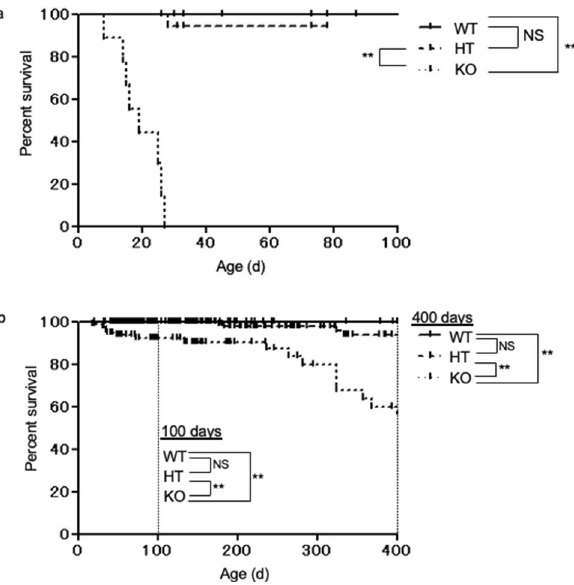
Figure 1. Survival curve for Kif26a-deficient (KO), heterozygous (HT), and wild type (WT) littermate mice of two different genetic backgrounds. ( a ) Survival curve of Kif26a mutant mice generated from C57BL/6 genetic background. WT (n = 27), HT (n = 17) and KO (n = 9) mice were observed up to 100 days. The median lifespan of the KO mice is the 19 days. The survival period of the KO mice is significantly shorter than WT and HT mice. ( b ) Survival curve of Kif26a mutant mice generated from the BALB/c genetic background. WT (n = 175), HT (n = 249), and KO (n = 98) mice were observed for more than 400 days. The median lifespan of the KO mice is 412 days. The survival period of KO mice is significantly shorter than that of WT and HT mice. The survival rate of KO mice was significantly lower than that of WT and HT mice, being 400 days. Furthermore, the survival rate of KO mice is significantly lower than that of WT and HT mice at 100 days (both p < 0.0001, log-rank test). *P < 0.05, **P < 0.01, NS not